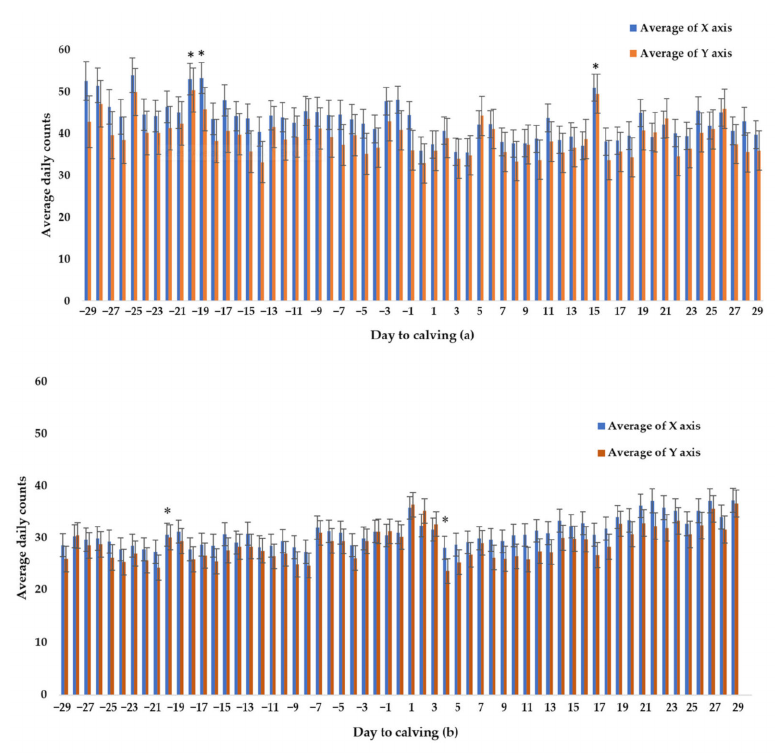
Figure 3. Average activity counts of the accelerometer X- and Y-axis for collared cows 30 days each side of the calving date for Trial 1 ( a ) and Trial 2 ( b ). Means with an Asterix (*) indicate a significant di ff erence from the day of calving ( p < 0.05). Means with two Asterix (**) indicate a significant di ff erence from day 1 ( p < 0.05). Only collared cows with a confirmed calving date ( n = 8 in Trial 1 and n = 7 in Trial 2) were included.